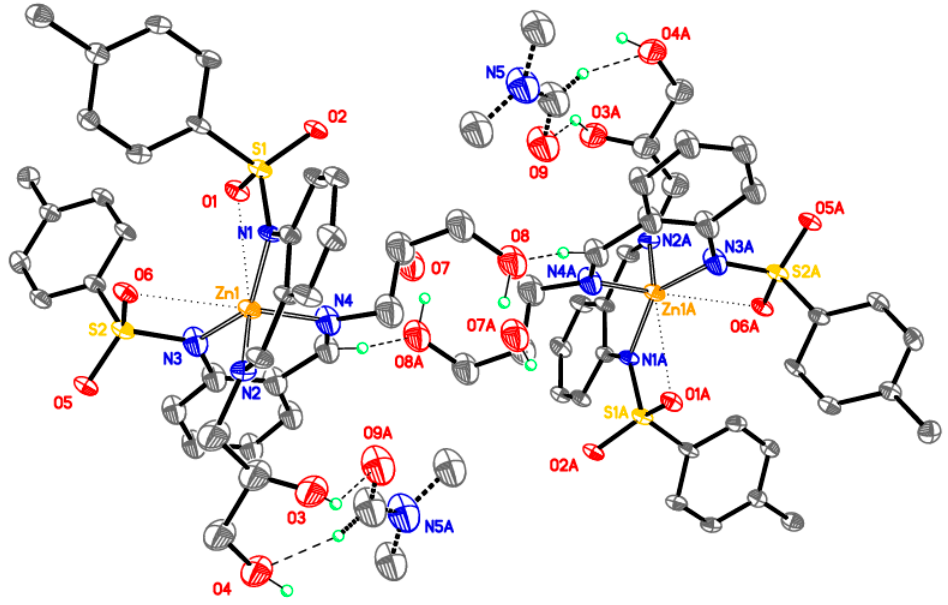
Figure 4. The centrosymmetric H-bonded dimers of 2-Zn . The solvate dimethylformamide molecules with the partial occupations are depicted by thick dashed lines. Thin dashed lines indicate the intermolecular hydrogen bonds; dotted lines indicate the secondary Zn···O interactions.